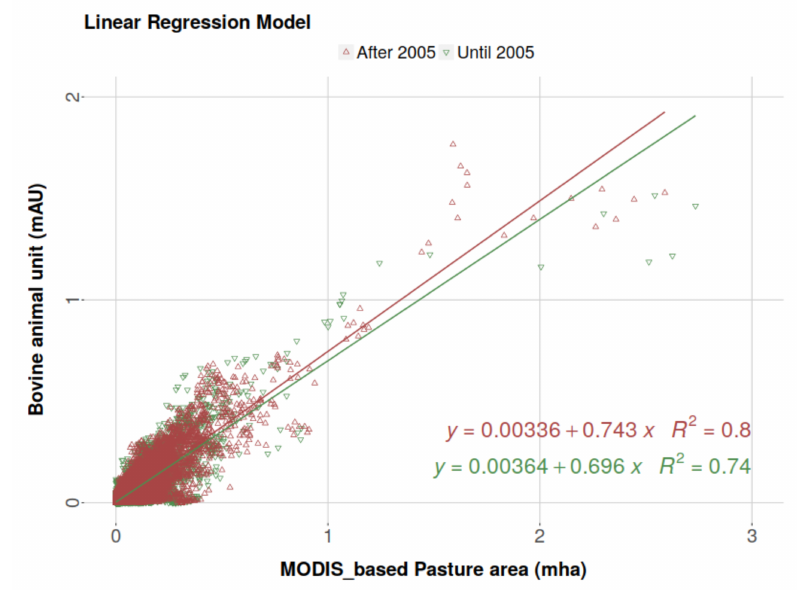
Figure 8. Linear regressions between pasture areas (based on MODIS data classification) and bovine animal units for all municipalities in Brazil, in two complementary periods (2000 to 2005 and 2006 to